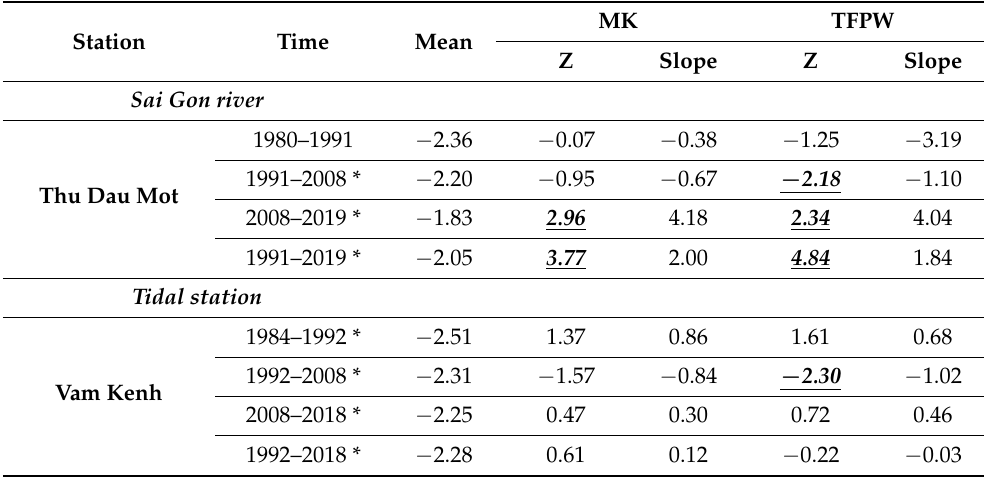
Table 10. Periodic water level trend at H min